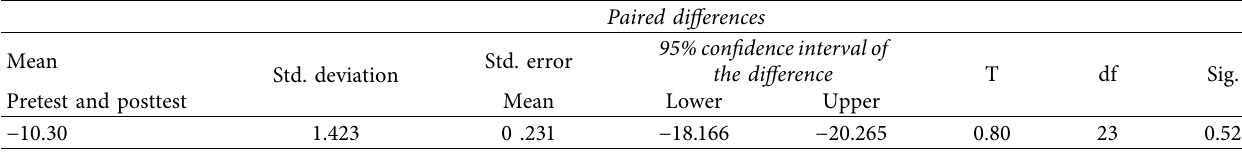
Table 9: Paired samples t -test for the control group (pretest Vs. posttest).